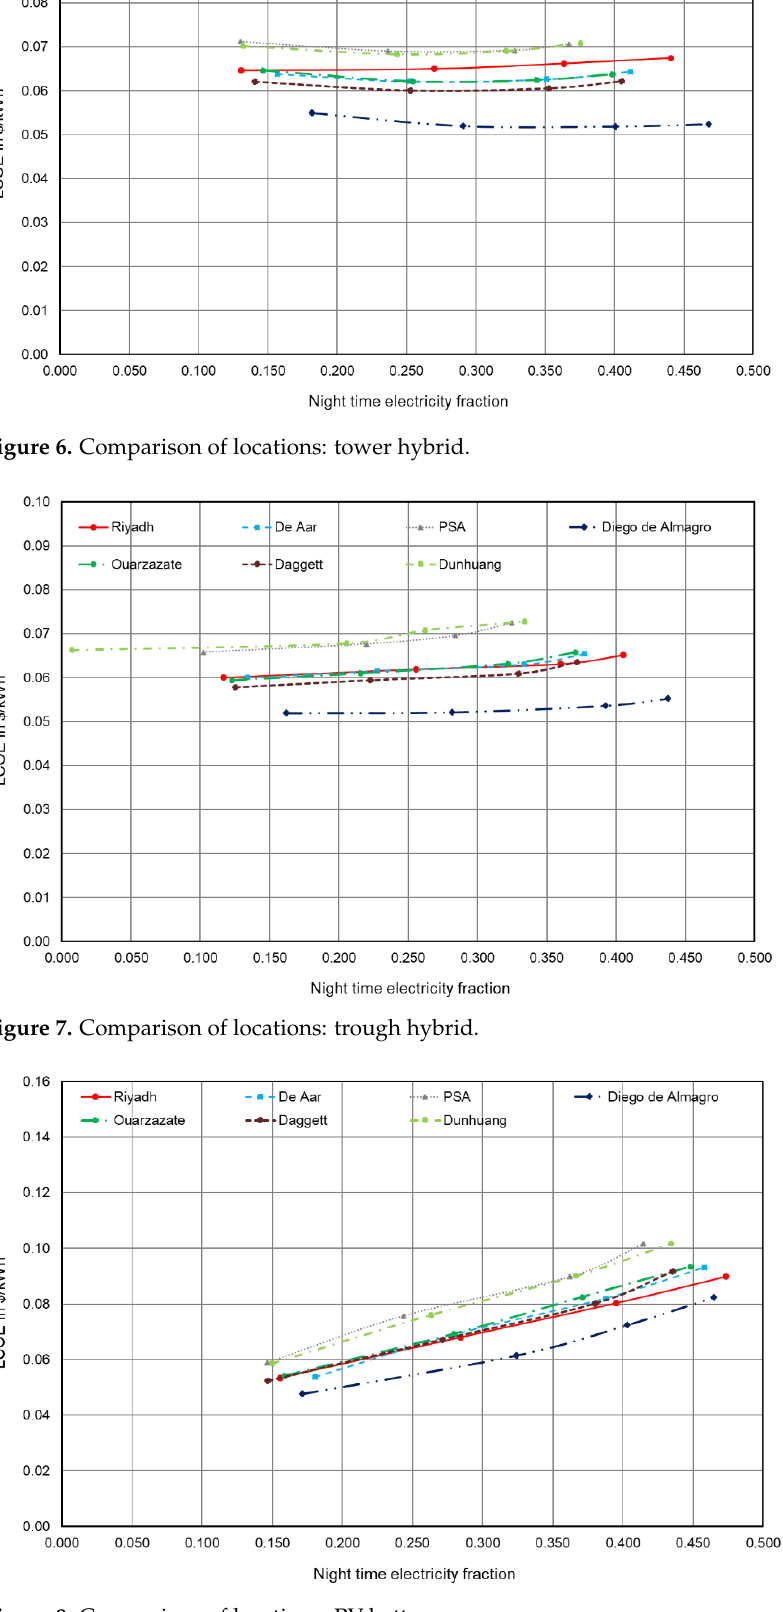
Figure 8. Comparison of locations: PV battery.